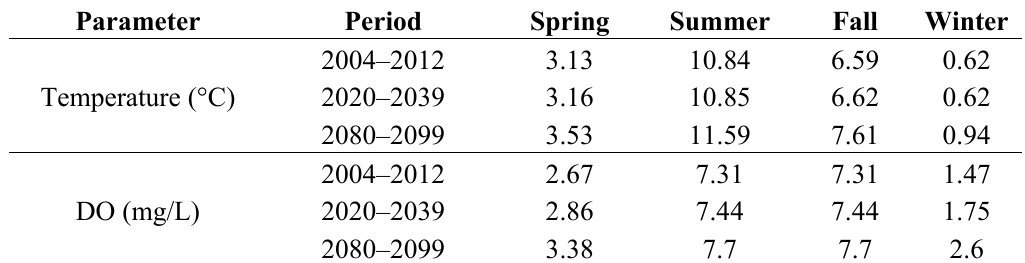
Table 5. The projected seasonal temperature and DO differences between surface